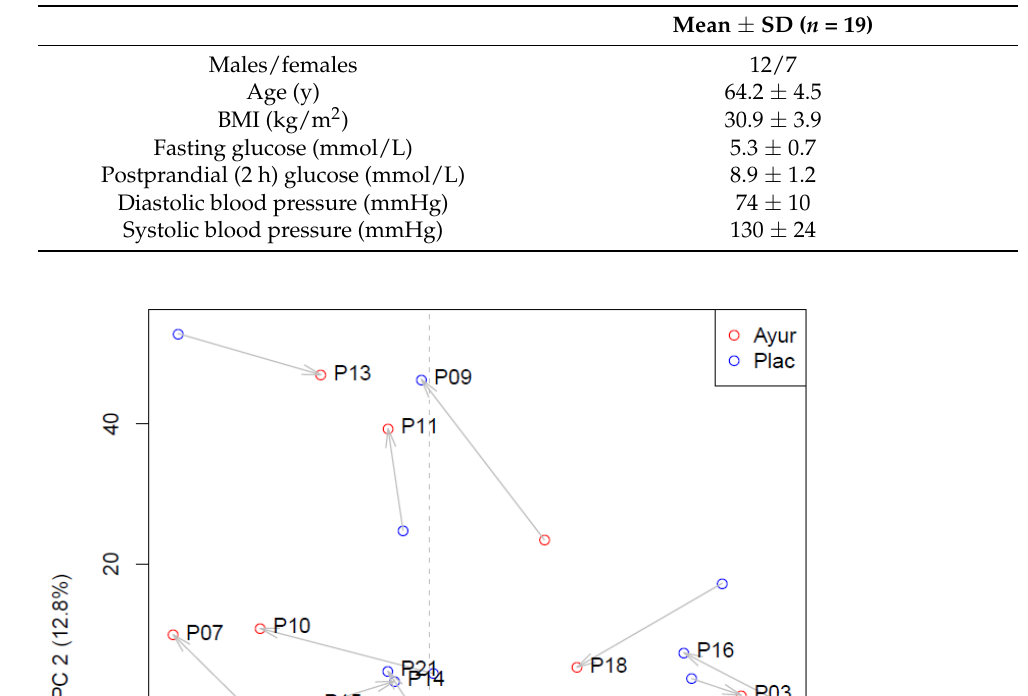
Table 2. Baseline characteristics of the subjects.